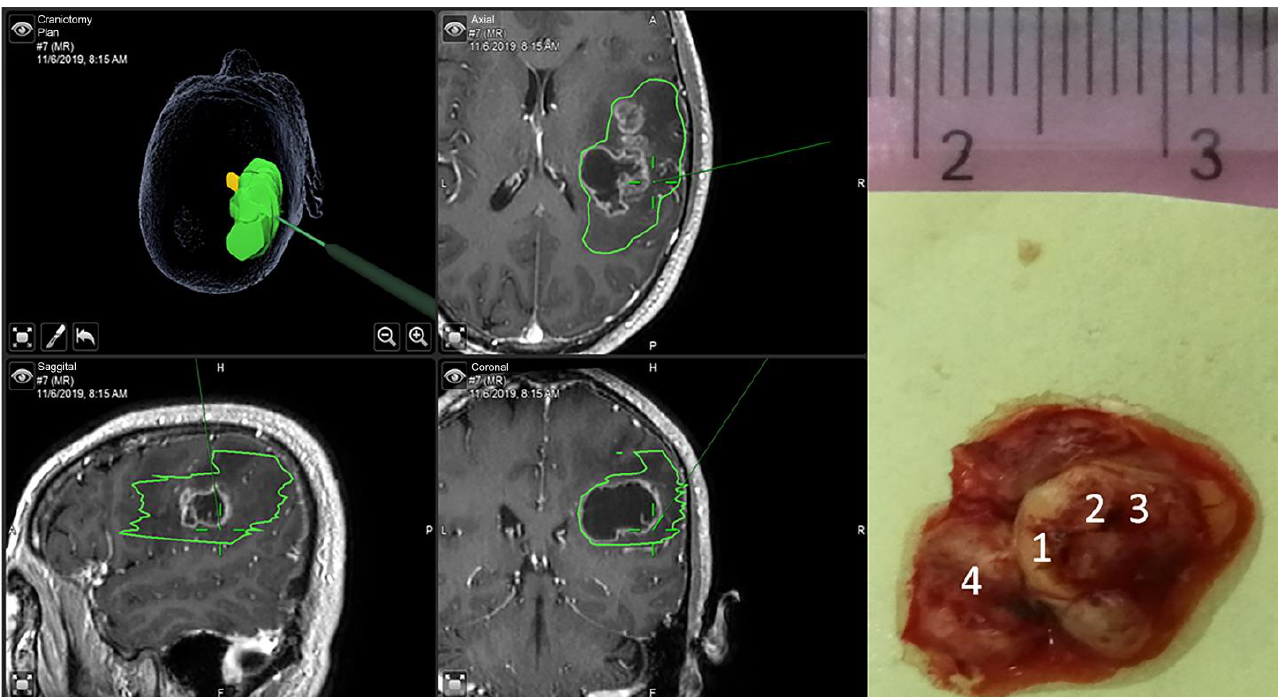
Figure 2. Magnetic resonance imaging (MRI) data were transferred to the neuro-navigation system (Brainlab, Germany), and demonstrated a large glioma in the left parietal lobe. The sample was obtained under a microscope with the guidance of intraoperative neuro-navigation. The spectra were obtained from 4 sites in the fresh unprocessed specimen immediately after resection. Spectra acquisition was performed using the VRR-LRR TM analyzer. The exposure time was 3 s, excitation laser wavelength 532 nm, with full scan range from 200 to 4000 cm − 1 for analysis of VRR spectra. The tumor was pathologically verified as glioblastoma (WHO grade 4).